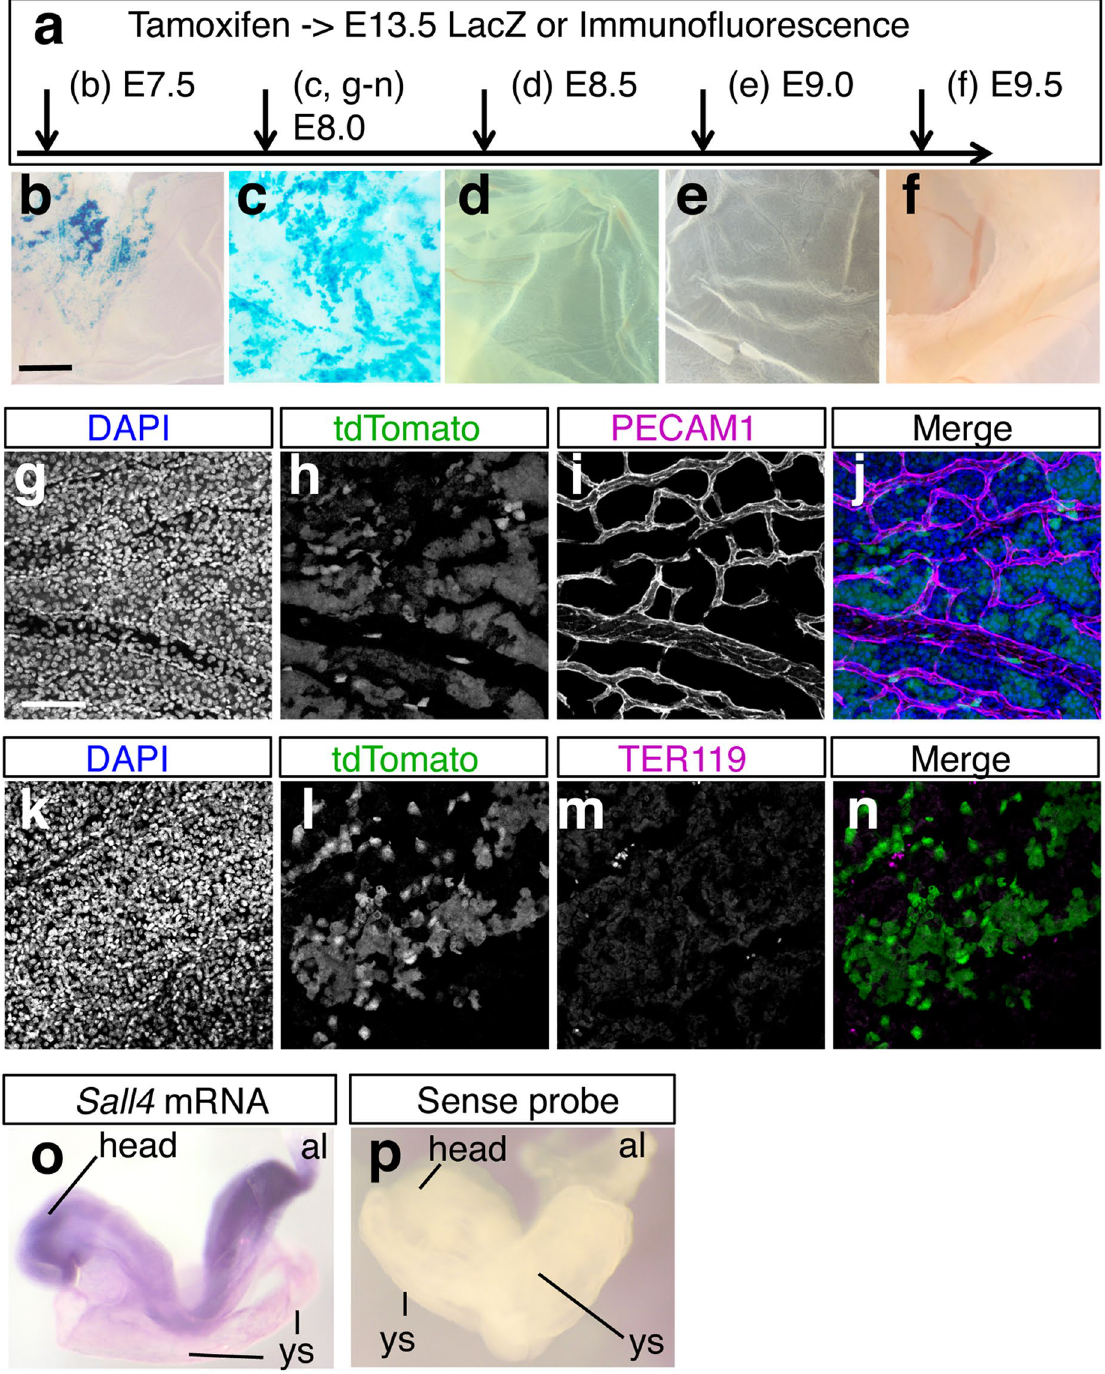
Figure 5. Sall4 lineage contribution to the yolk sac stroma in a narrow time window. Schematic of tamoxifen injections at different time points of embryonic development. ( b – f ) LacZ-stained yolk sac. The staining was broadly detected when tamoxifen was injected at E8.0. Scale bar in panel b: 1 mm. Panels b to f are in the same scale. ( g – n ) Immunofluorescence images of DAPI ( g , k ), tdTomato ( h , l ), PECAM ( i ) and TER119 ( m ). ( j ) and ( n ) show merged images of ( g – i ) and ( k – m ), respectively. The tdTomato signals do not overlap with PECAM and TER119. Scale bar in panel g: 100 µ m. Panels g to n are in the same scale. ( o , p ) Lateral views of E8.5 embryos hybridized with antisense ( o ) or sense ( p ) Sall4 probes. Sall4 is expressed in the yolk sac (ys) and the allantois (al), in addition to the embryo. Control sense probe generated no signals. Abbreviations. al: allantois, ys: yolk